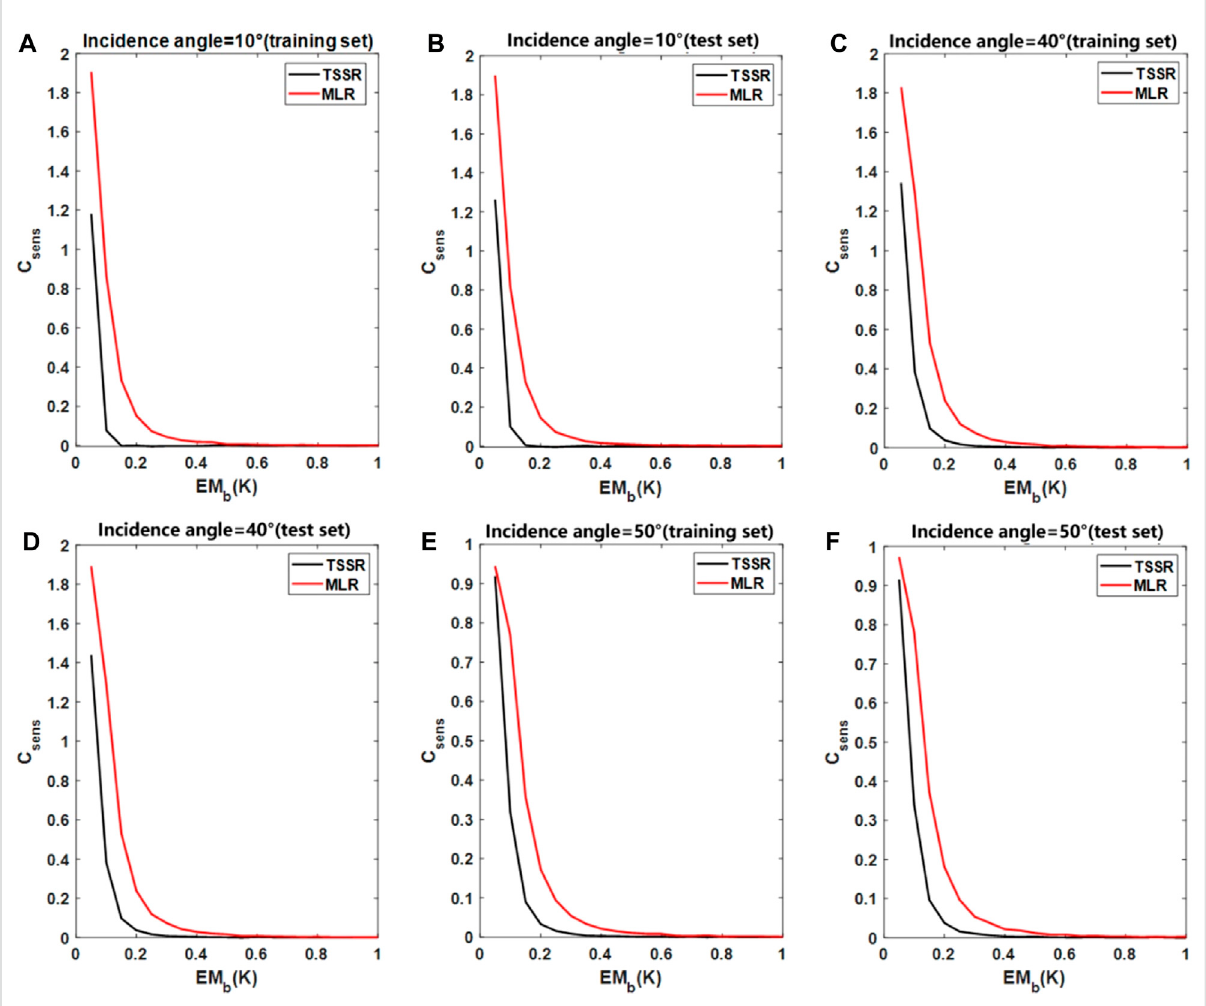
FIGURE 7 Relationship between C sens and EM b for differentantenna angles. (A,B) theincidence is10 ° , (C,D) the incidence is 40 ° , (E,F) the incidence is 60 °